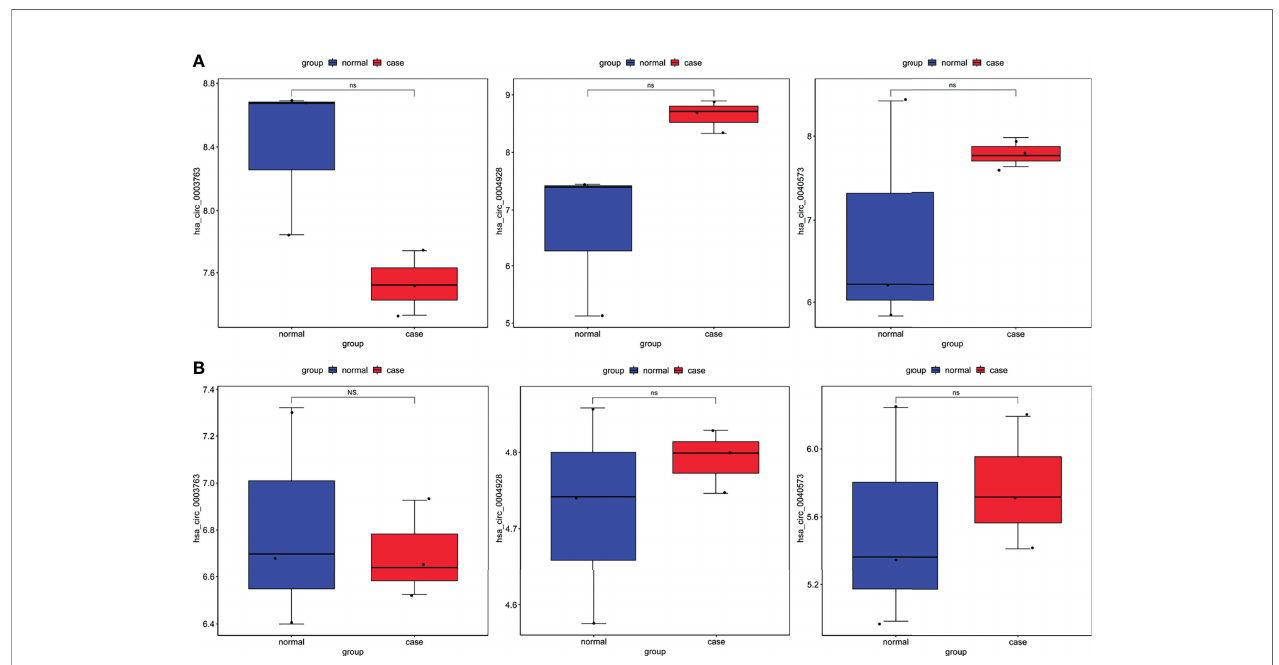
FIGURE 11 | Expression validation of hsa_circ_0003763, hsa_circ_0004928, and hsa_circ_0040573 in the GSE93541 dataset (A) and GSE141977 dataset (B) . Ns, no signi fi cant difference.